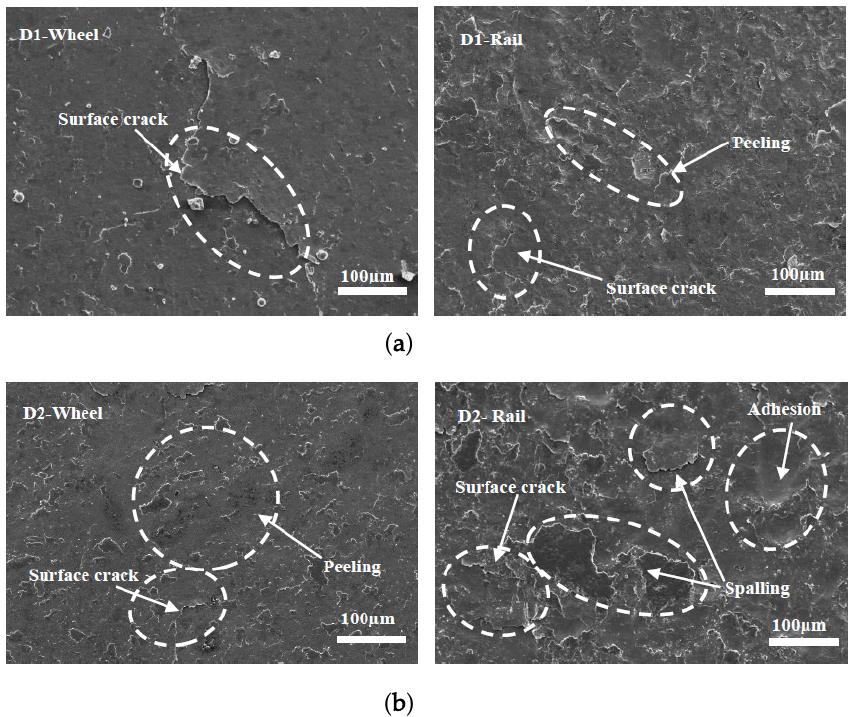
Figure 14. Micrographs of the worn surfaces of the wheel and rail rollers at − 30 °C, (a) D1; (b) D2.